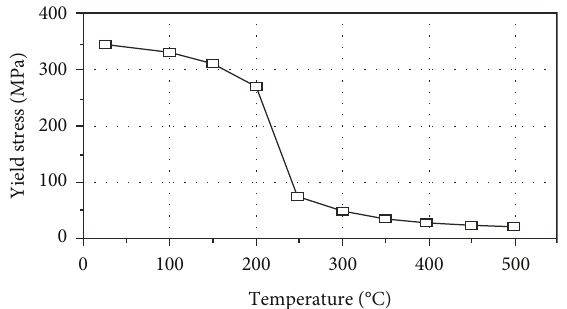
Figure 3: Yield strength of AA2024-T3 at different temperature [21].